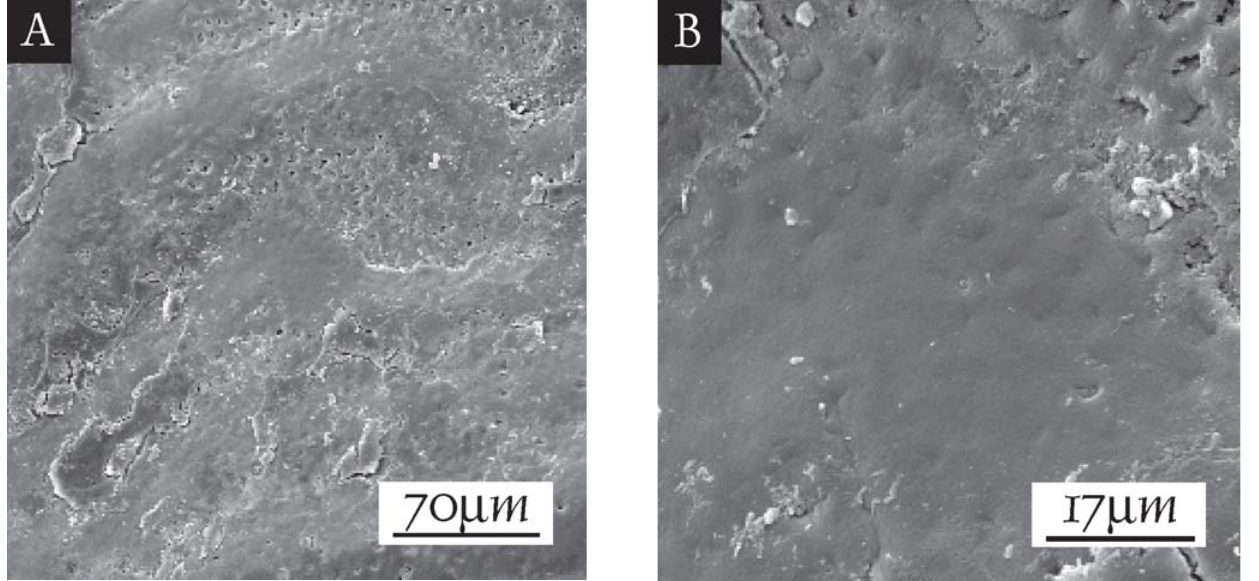
FIGURE 1- Photomicrographs of unbleached enamel (control group) at 500x (A) and 2000x magnifications